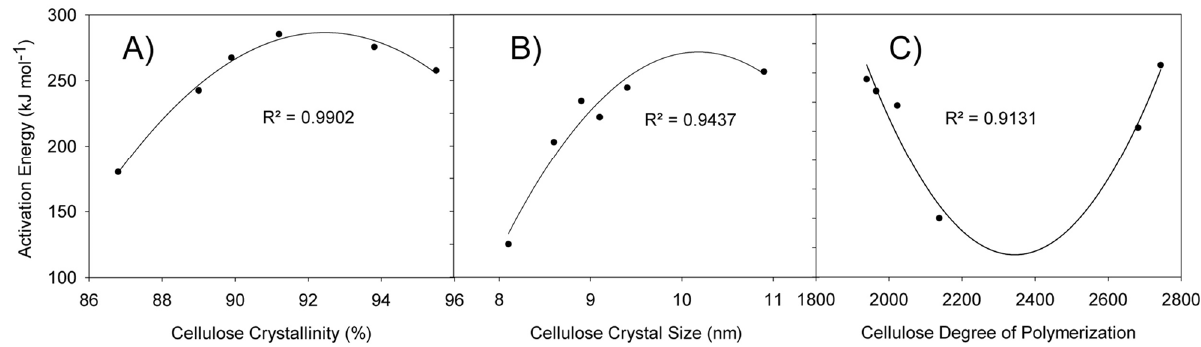
Figure 2. Yielded equations among activation energy and cellulose crystallinity ( A ), cellulose crystal size ( B ), and degree of polymerization ( C ).